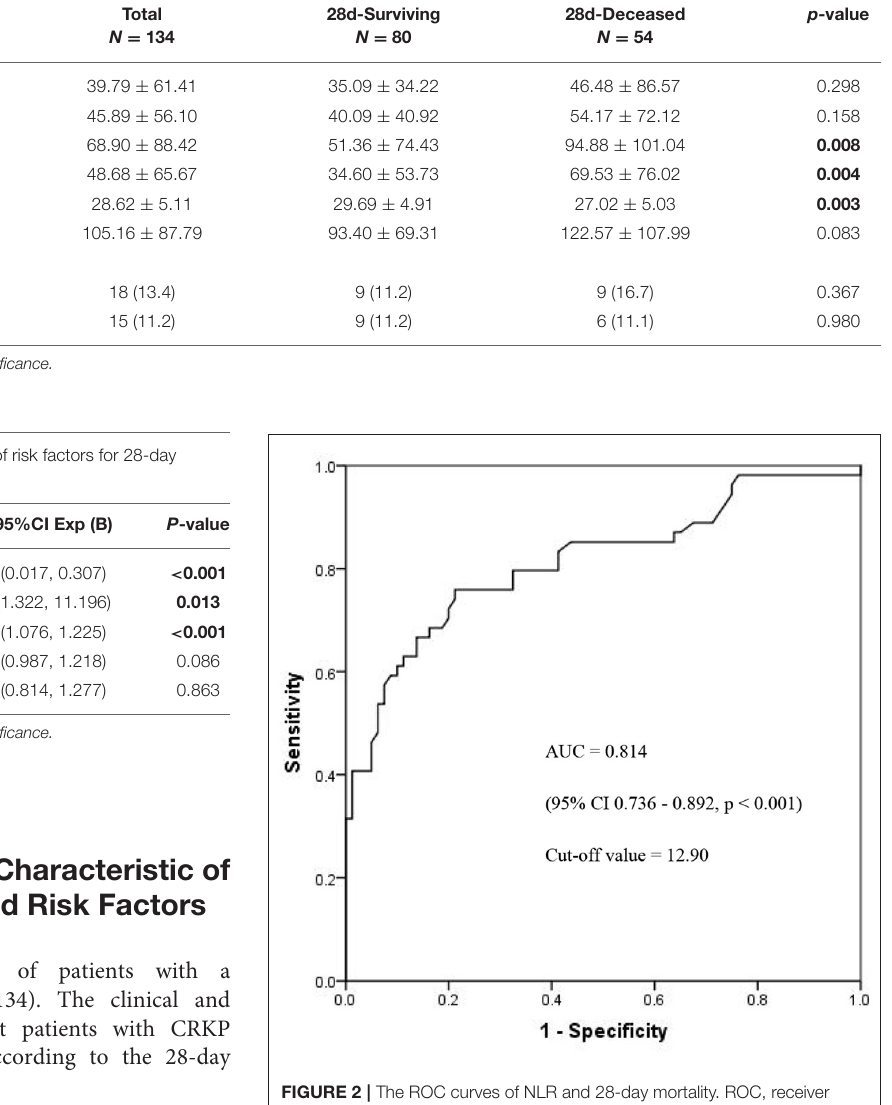
FIGURE 2 | The ROC curves of NLR and 28-day mortality. ROC, receiver operating characteristic; NLR, neutrophil- to-lymphocyte count ratio; AUC, area under